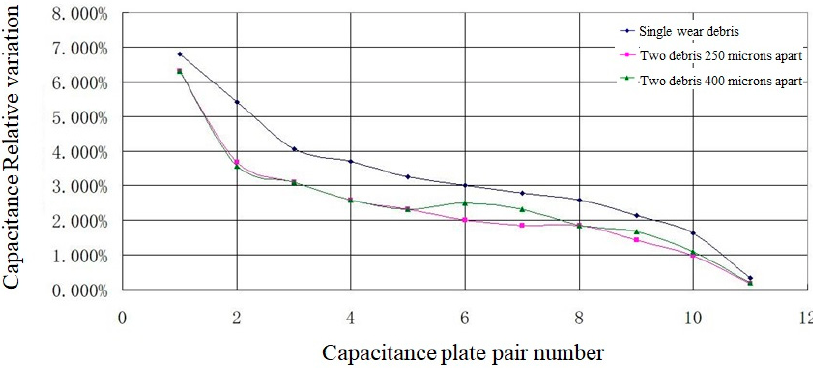
Figure 4. Wear debris Resolution with Different Distributions.